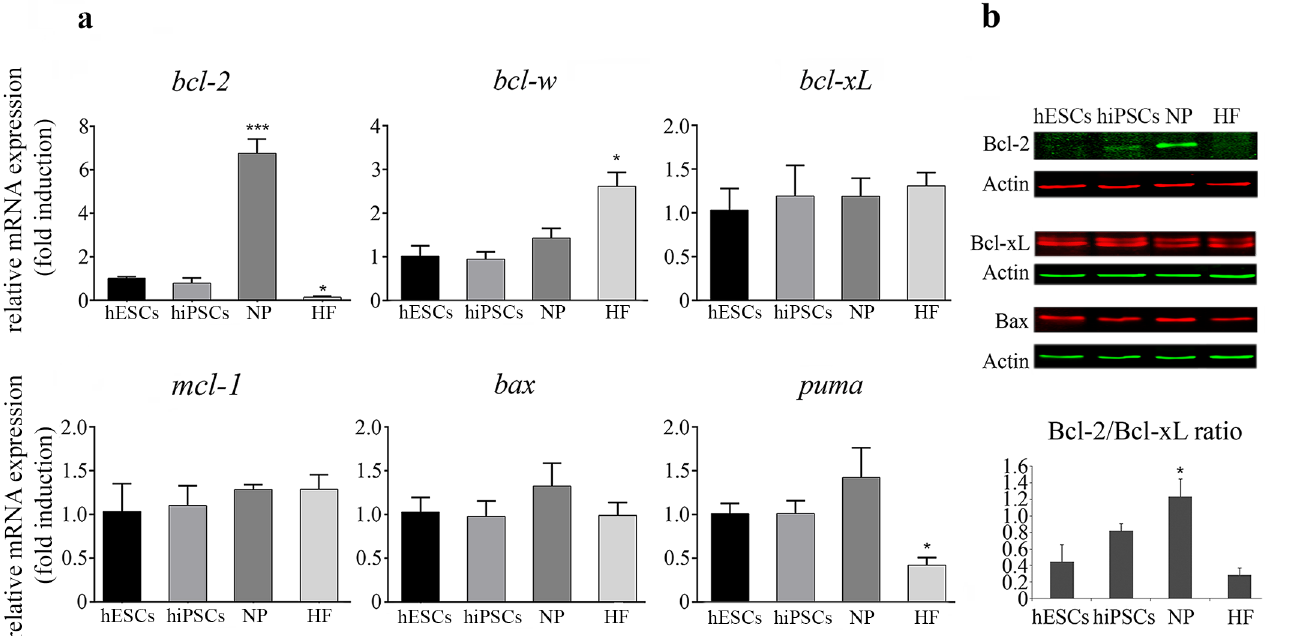
Fig 4. Bcl-2 family members expression profile in hESCs, hiPSCs, hESCs-derived NP and HF. (a) mRNA expression levels of bcl-2 , bcl-w , bcl-xL , mcl- 1 , bax and puma were analyzed by Real Time quantitative RT-PCR in hESCs, hiPSCs, NP and HF. GAPDH expression was used as normalizer. Graph shows mRNA fold induction relative to hESCs arbitrarily set as 1. The mean ± S.E. from three independent experiments are shown. In all cases, a paired Student's t test was used to test for significant differences between hESCs and each cell line tested * P < 0.05, *** P < 0.0001. (b) Representative Western blot images are shown. Cellular extracts were prepared and Western blot analyses were carried out using anti-Bcl-2, anti-Bcl-xL and anti-Bax specific antibodies. Actin served as loading control (top panel). Intensities of protein bands corresponding to Bcl-2 and Bcl-xL were measured using computer- assisted densitometric analysis and normalized to the intensity of Actin. Intensities of Bcl-2 and Bcl-xL were also compared to each other and presented as the average ratio for each cell line (bottom panel). A paired Student's t test was performed to test for significant differences between hESCs and each cell line tested * P <